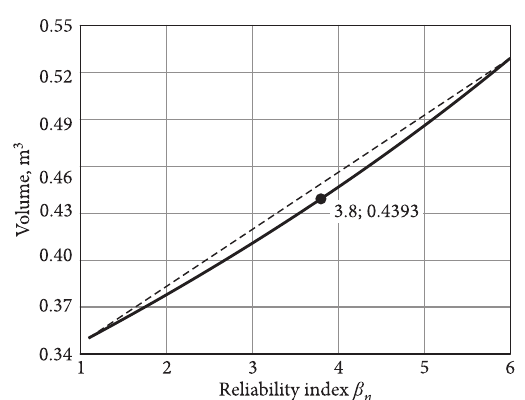
Fig. 6. Truss volume dependence on the reliability index β